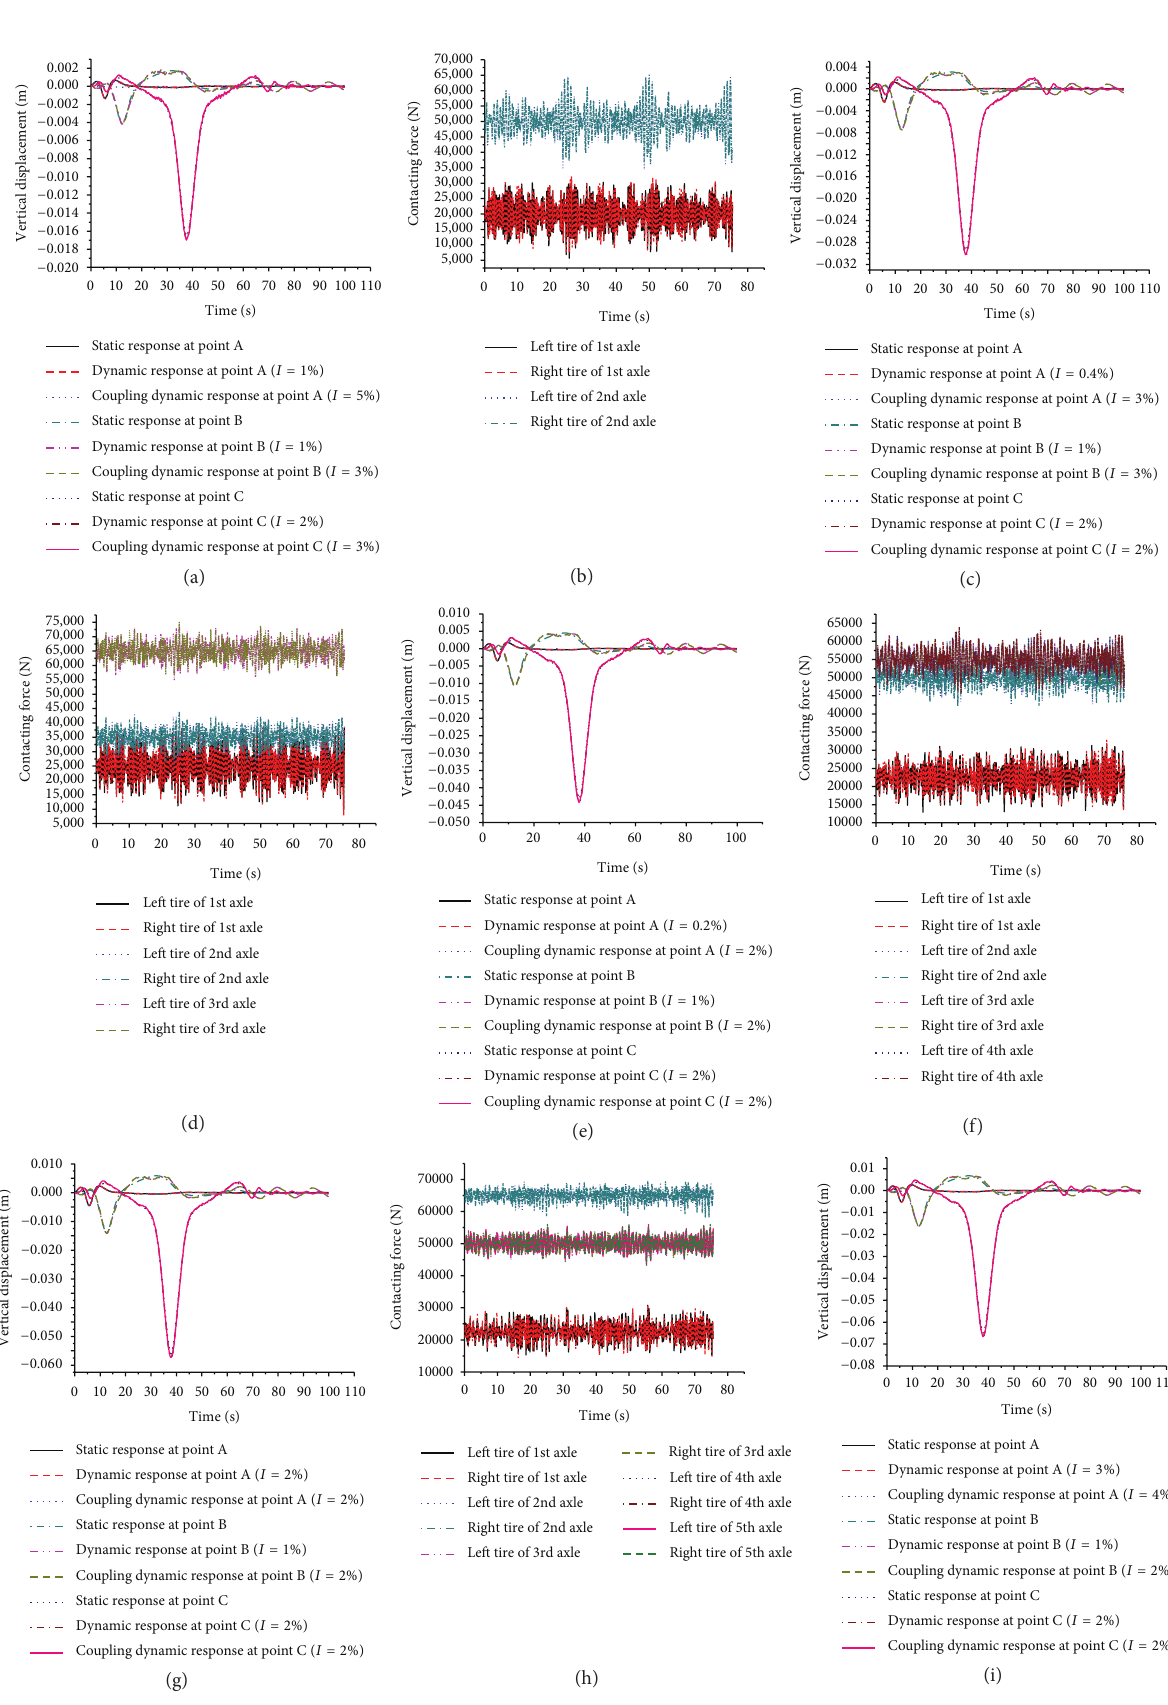
Static response at point A Coupling dynamic response at point A (I = 4%) Static response at point B Dynamic response at point B (I = 1%) Coupling dynamic response at point B (I = 2%)